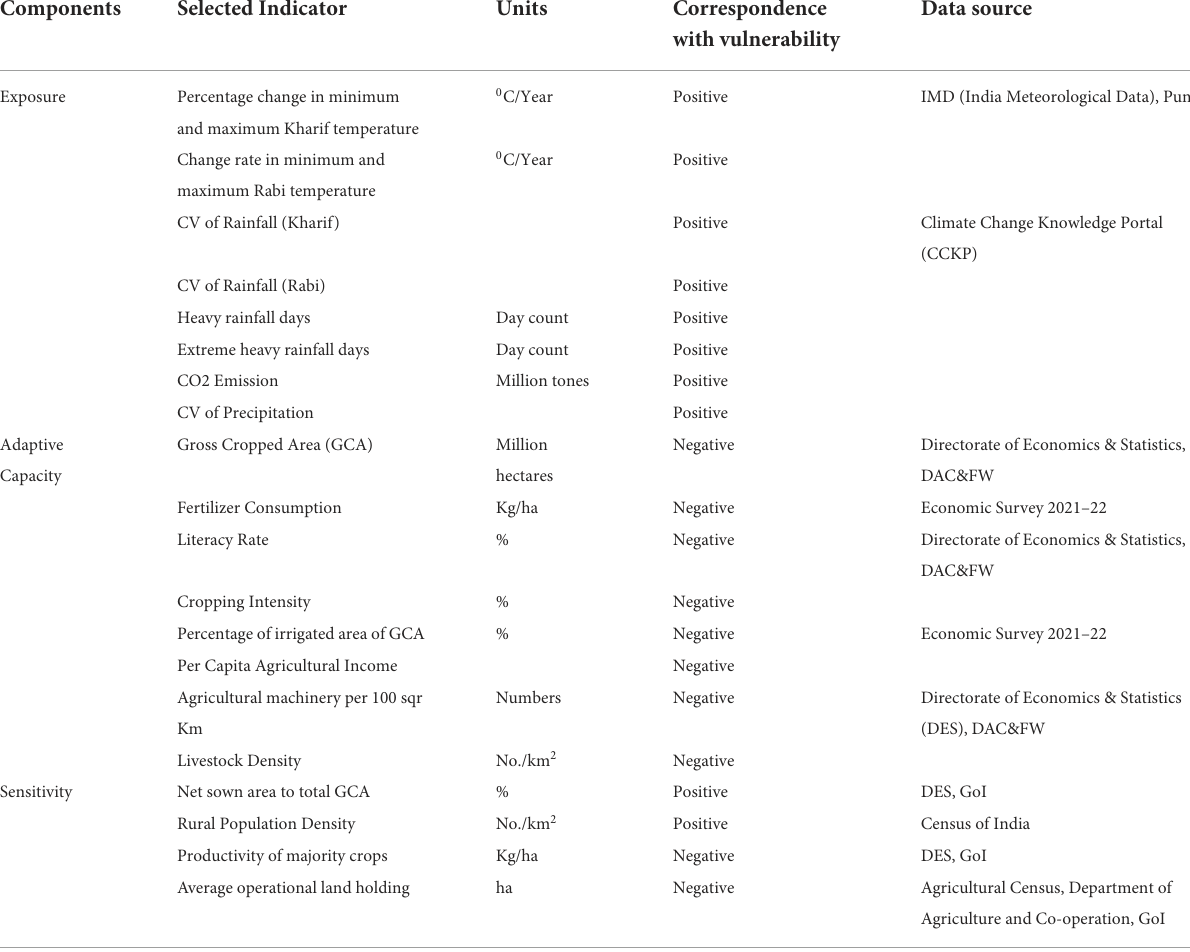
TABLE 1 Selected indicators and their effective correspondence with vulnerability.